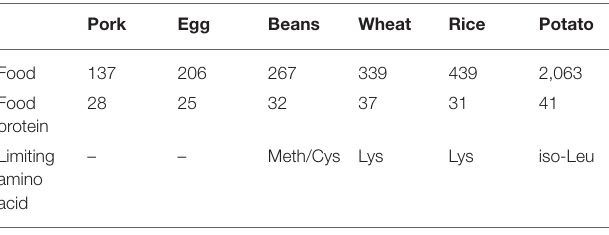
TABLE 1 | Amounts (g) of food or food protein to provide the recommended daily allowance for the corresponding limiting essential amino acid, referred to a 70-kg man, considering a protein content of 21, 11, 12, 11, 7, and 2% for pork, egg, beans, wheat, rice, and potato,